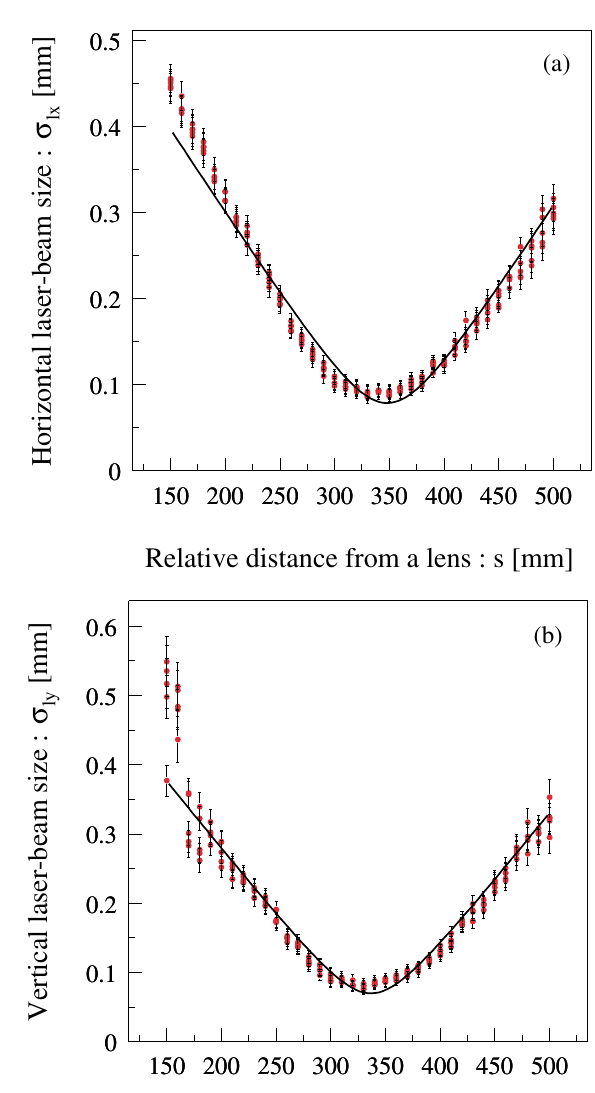
FIG. 14. (Color) Laser-beam size as a function of the relative distance from a lens of f (cid:2) 2000 mm for the laser emittance measurement: (a) for the horizontal direction; (b) for the vertical direction.